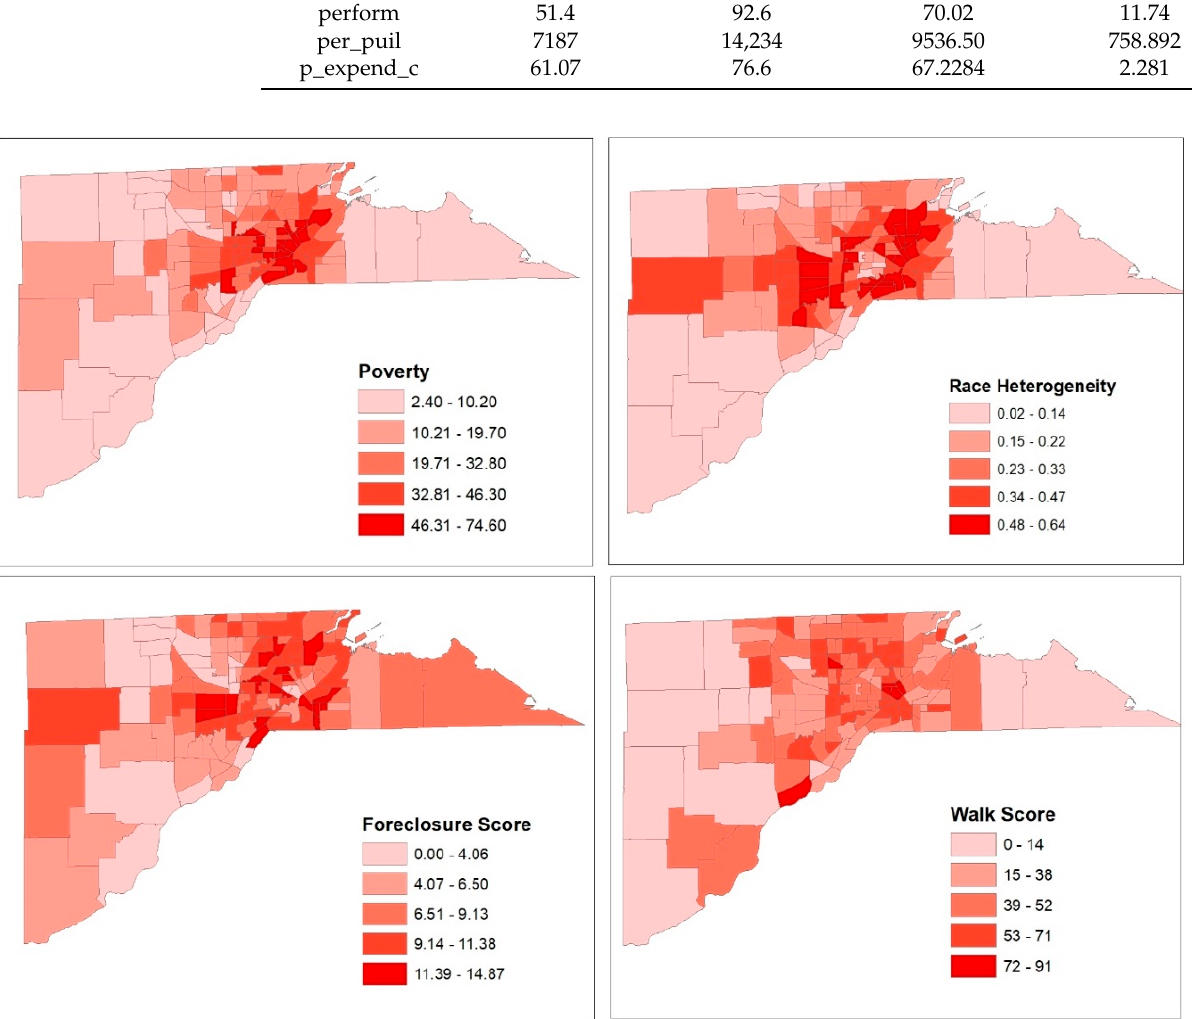
Figure 4. Distribution patterns of variables: poverty, race heterogeneity, foreclosure score, and walk score.